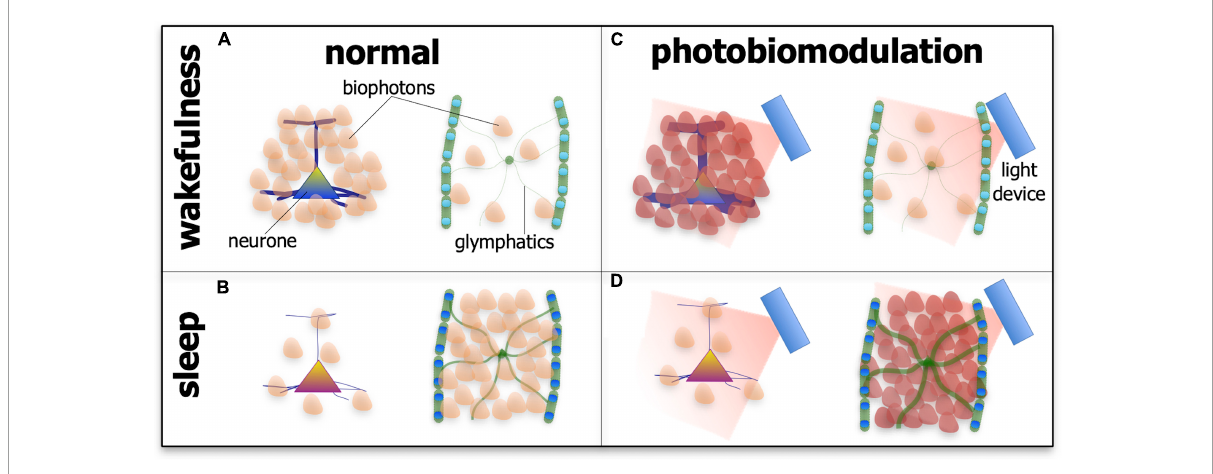
FIGURE6 Schematic diagram showing the suspected patterns of biophoton emissions – the endogenous light from cells – in neurones and the glymphatic system during wakefulness (A,C) and sleep (B,D) and in normal tissue (A,B) and after photobiomodulation treatment. During wakefulness in normal tissue (A) , the activity of neurones is high (represented by thick processes and many biophoton shapes), while glymphatic activity is low (represented by thin processes and few biophoton shapes). During sleep in normal tissue (B) , the activity of neurones is low (represented by thin processes and few biophoton shapes), while glymphatic activity is high (represented by thick processes and many biophoton shapes). After photobiomodulation treatment, activity is increased further in neurones during wakefulness [ (C) ; represented by thick processes and many darker biophoton shapes] and in the glymphatics during sleep [ (D) ; represented by thick processes and many darker biophoton shapes]. Photobiomodulation may have less of an effect on neurones during sleep [ (D) ; represented by thin processes and few biophoton shapes] and on the glymphatics during wakefulness [ (C) ; represented by thin processes and few biophoton